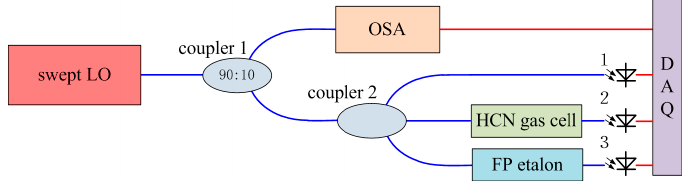
Figure 10. Schematic diagram of the RTWC system.